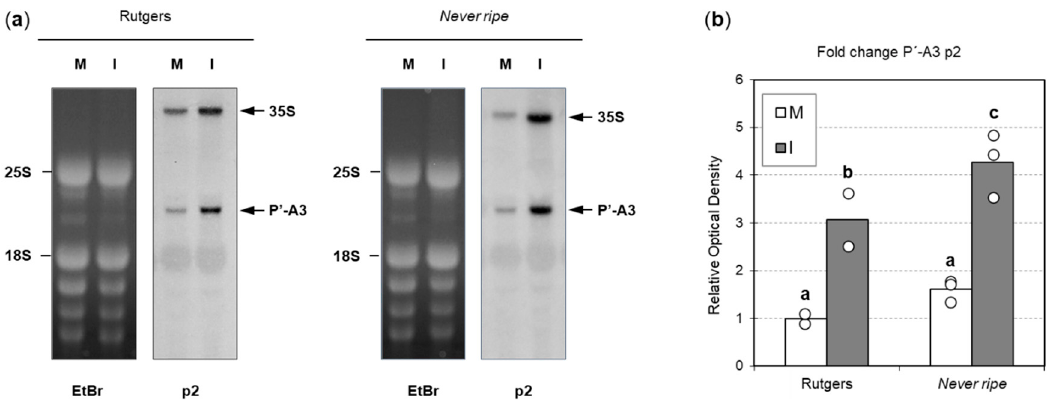
Figure 9. Alterations in tomato rRNA processing upon CEVd infection. ( a ) RNAs from Rutgers (left) and Nr (right), mock (M) and CEVd infected (I) tomato leaves were separated on an agarose gel, stained with ethidium bromide (EtBr) for the visualization of the 25S and 18S mature RNAs (left panels), and then were hybridized with the p2 probe for the detection of pre ‐ rRNA 35S and P’ ‐ A3, marked on the right with an arrow (right panels). ( b ) Quantification of P’ ‐ A3 accumulation in Rutgers and Nr plants. Data correspond to the mean ± SD of 2 ‐ 3 biological replicates and their individual values (open dots). Results were analyzed using a Mann–Whitney test and different letters indicate significant differences ( p < 0.05).